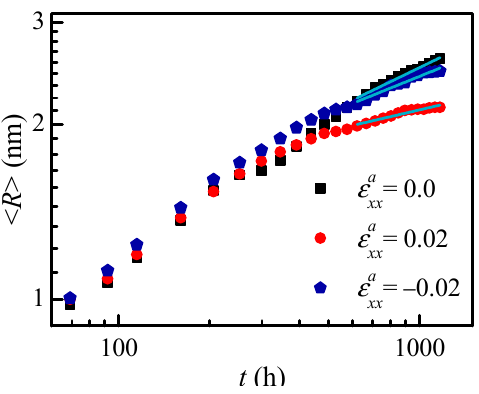
Figure 5. The temporal evolution of the average particle radius < R > of the α′ phase in Fe-28 at. % Cr alloy aged at 750 K under applied strain.